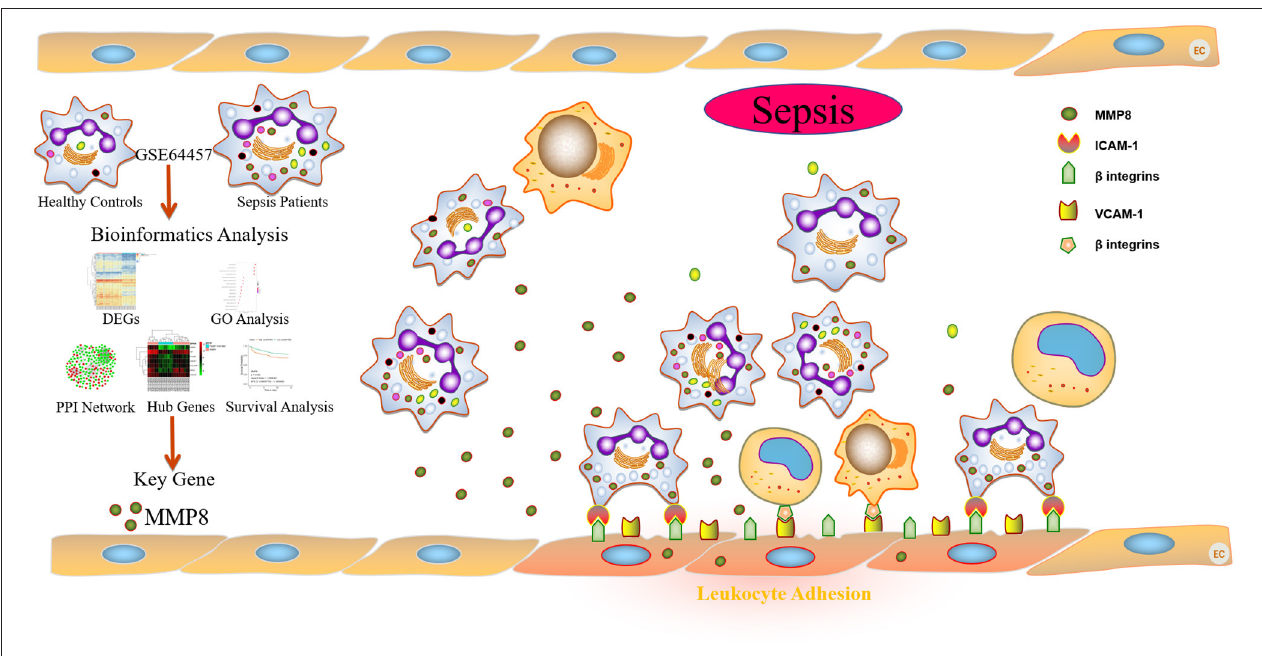
FIGURE 6 | Schematic summary of the in silico and in vitro study of sepsis serum promotes leukocyte adhesion to HUVEC via